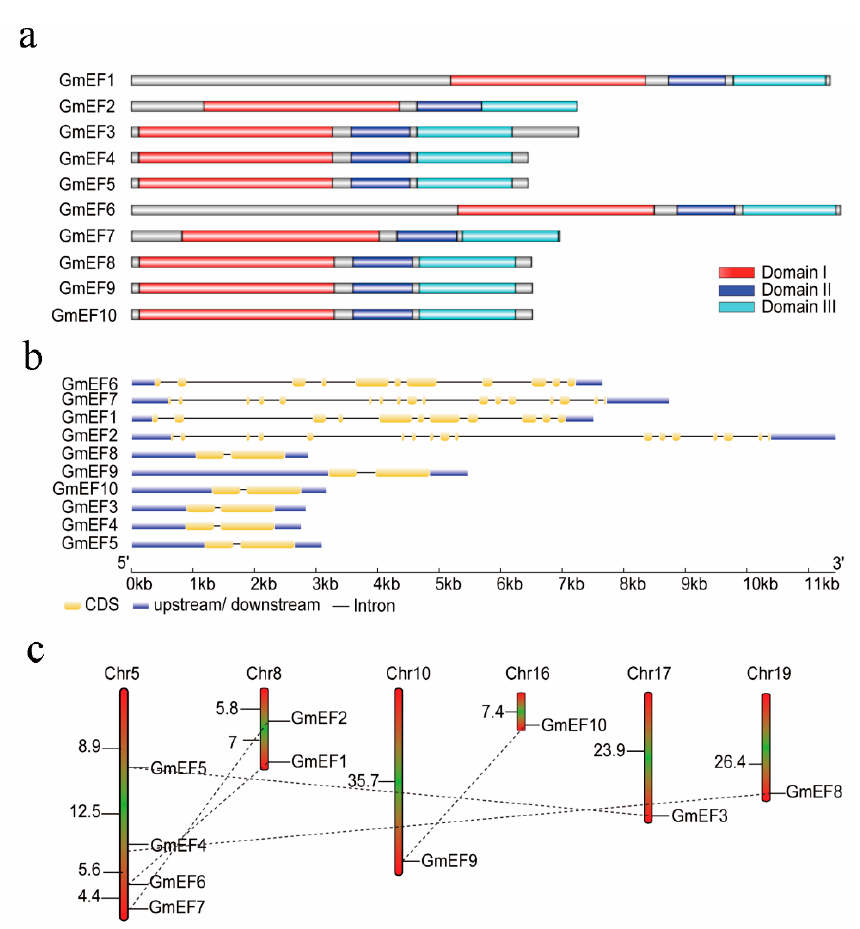
Figure 1. Bioinformatic analysis of GmEF1 α proteins and GmEF1 α genes. ( a ) Structures of EF1 α proteins in soybean. ( b ) Intron–exon structures of EF1 α genes in soybean. ( c ) Locations and duplications of GmEF1 α genes in the soybean genome. Paralogous genes are connected by